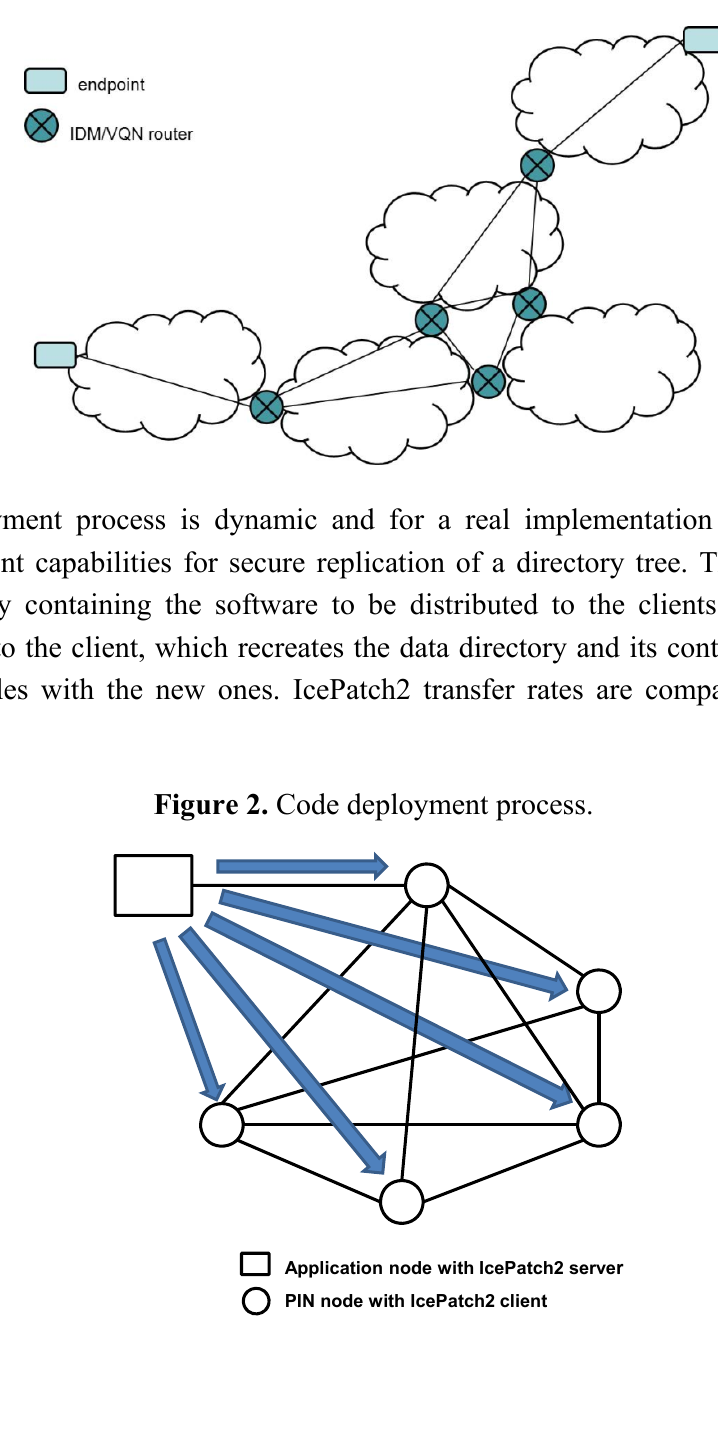
Figure 1. An IDM/VQN inter-network.